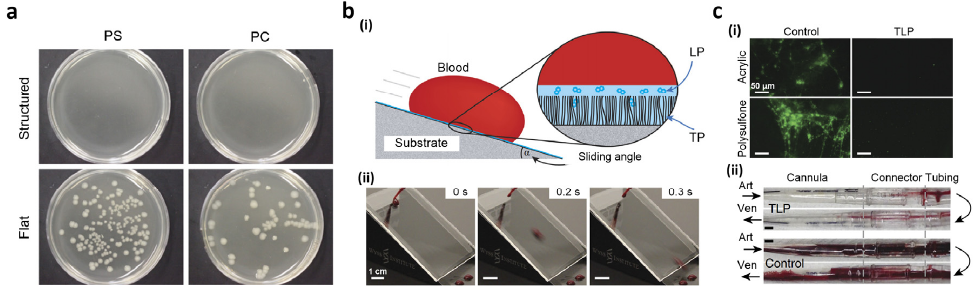
Figure 10. ( a ) The bacterial growth on the PS and polycarbonate (PC) structured and flat